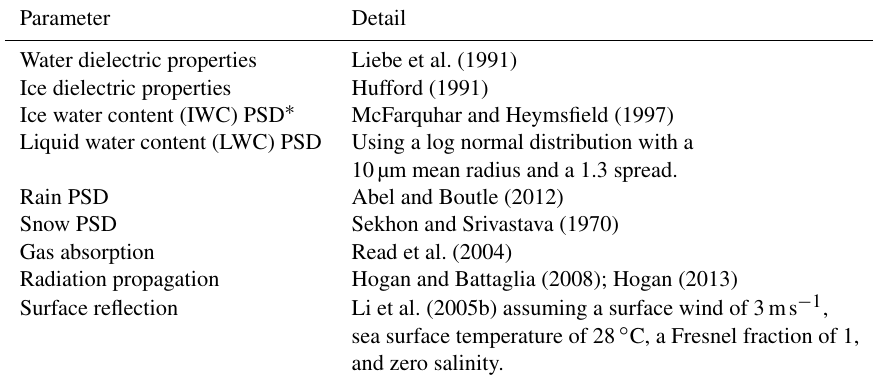
Table 1. Radar model specifics